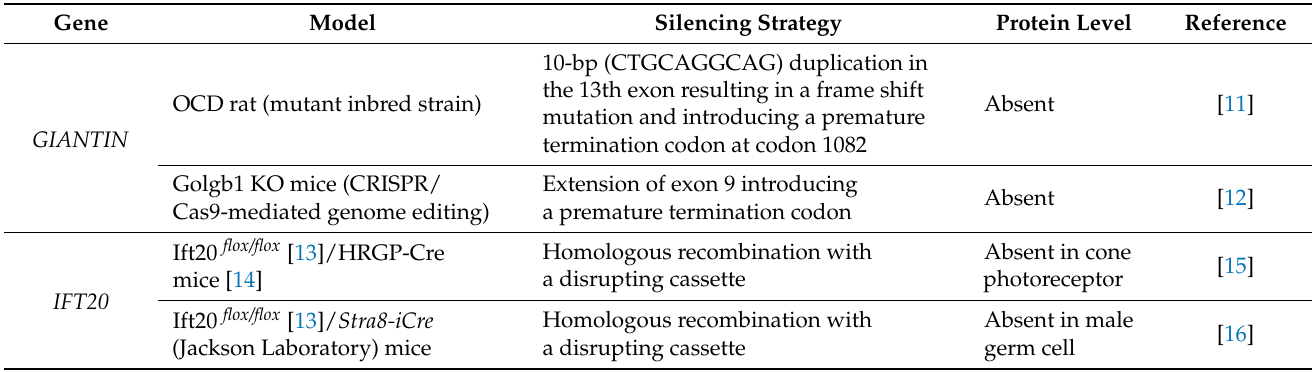
Table 2. List of mammalian animal models lacking expression of GA and GA-associated